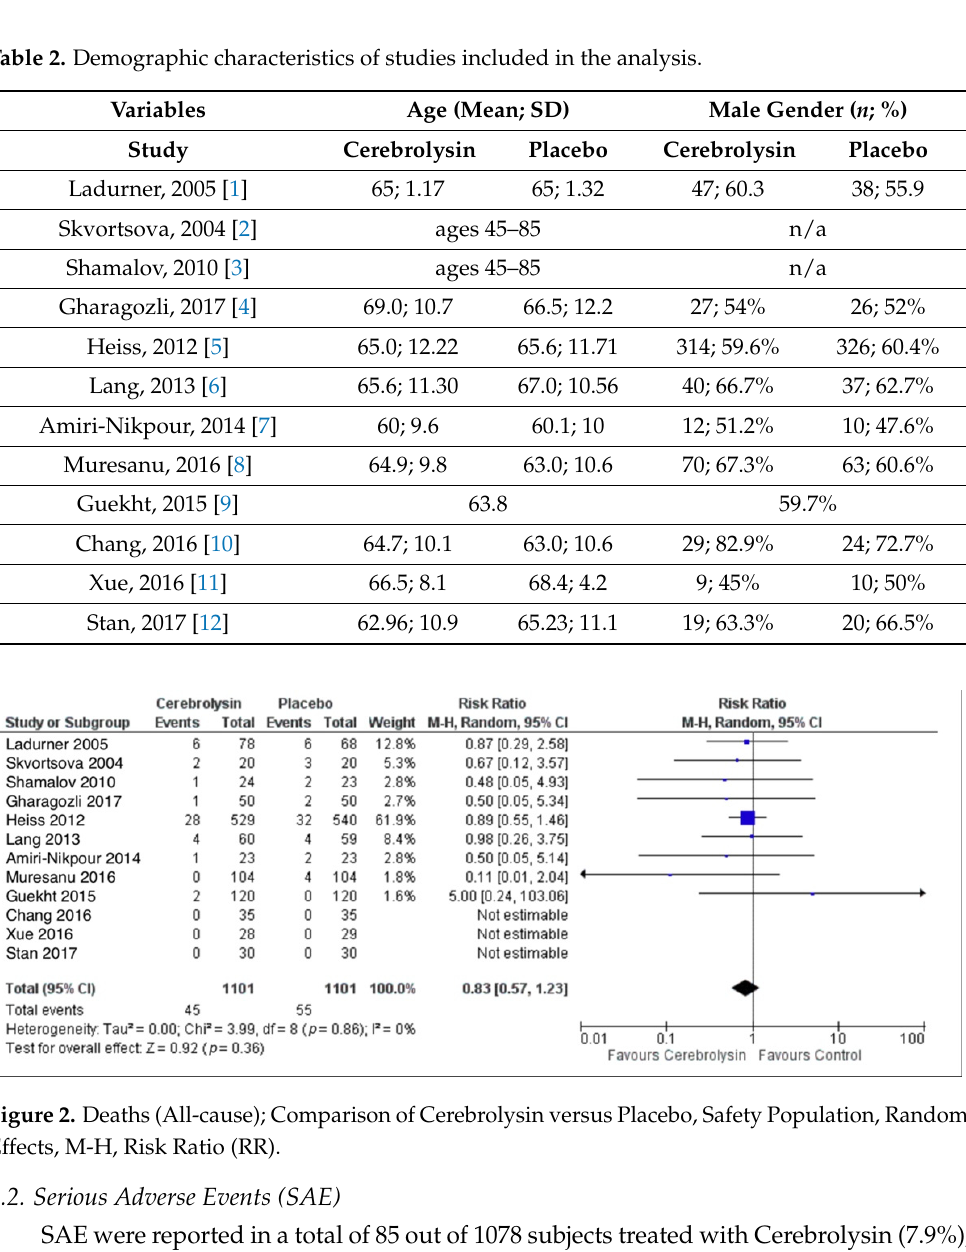
Table 2. Demographic characteristics of studies included in the analysis .